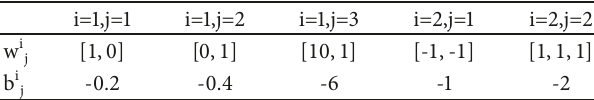
Table 1: Parameters of perceptron neural network.